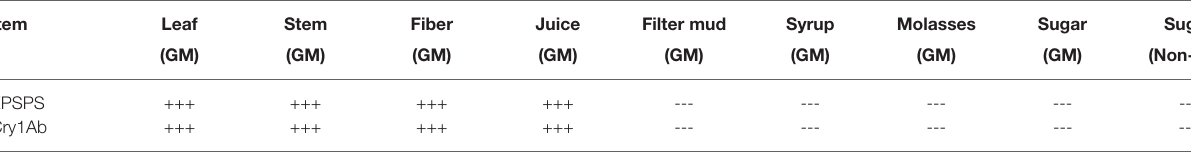
TABLE 6 | ELISA results of all